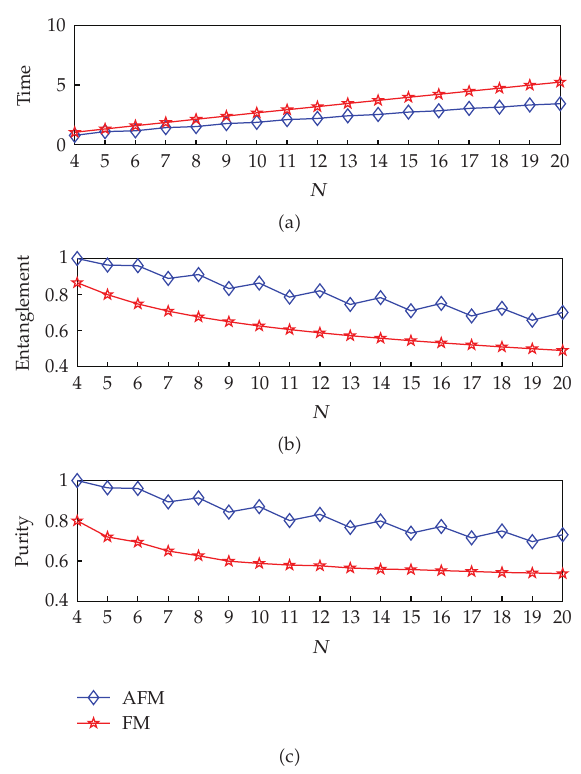
Figure 2: (cid:4) Color online (cid:5) In this figure we have plotted the time of first maximum and the amount of entanglement and also purity versus length for both cases FM and AFM chains versus the length of the